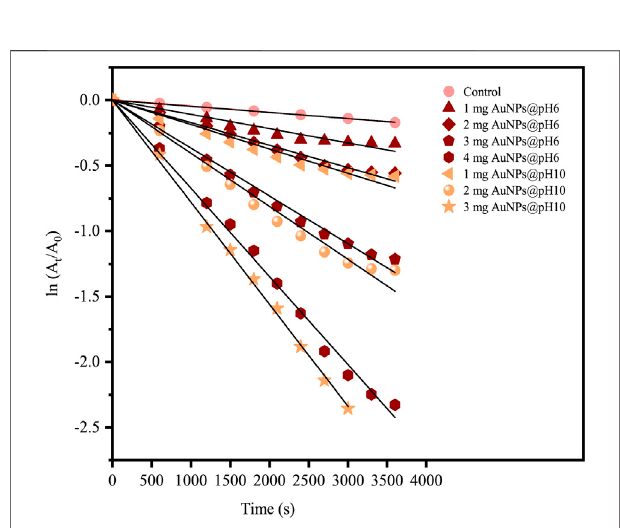
FIGURE 14 | A plot of ln (A t /A 0 ) versus time (s) for the reduction of 4-NP using biosynthesized CB-AuNPs.